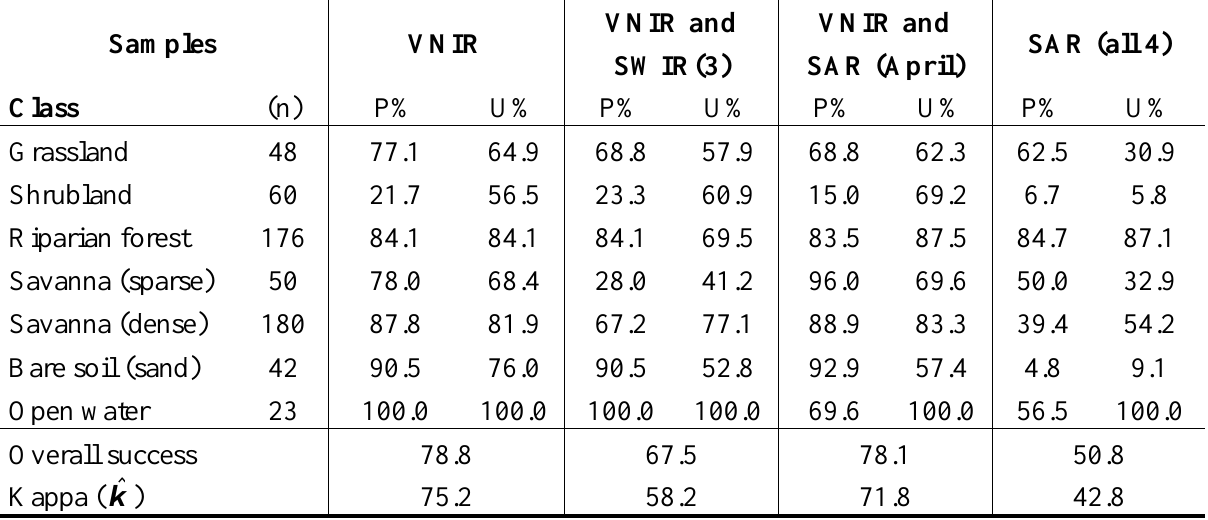
Table 7. Classification accuracy obtained from the different subset of features for the classification of vegetation types of the veredas and surroundings (P% represents the producer’s accuracy and U% the